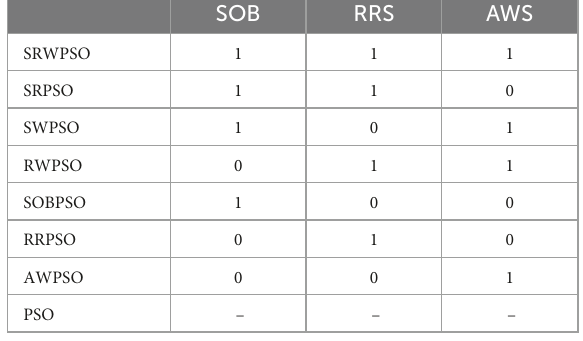
TABLE 5 The results of strategy combinations.